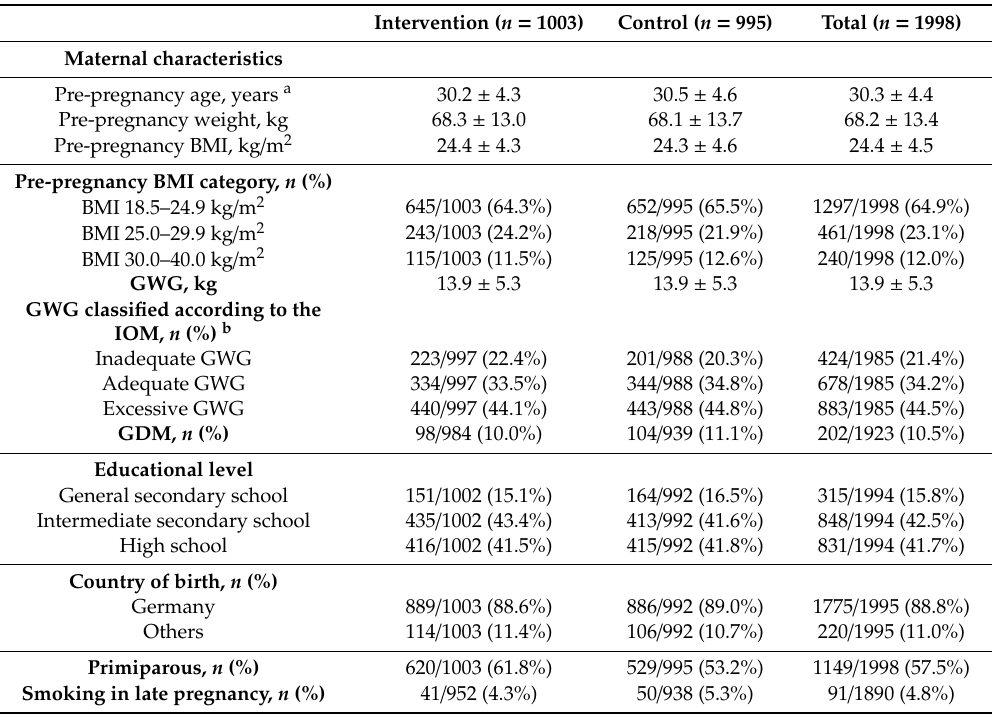
Table 1. Baseline characteristics of participants entering the